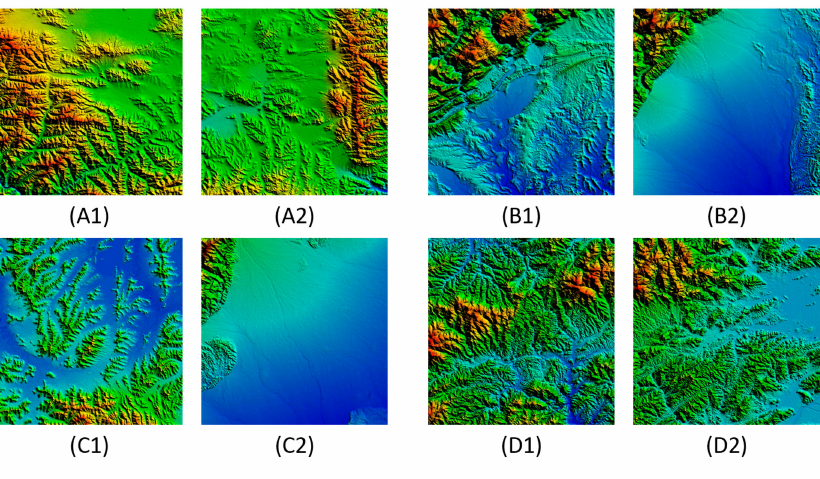
Figure 6. Four pairs of digital elevation models (DEMs) [51], namely A1 and A2, B1 and B2, C1 and C2, and D1 and